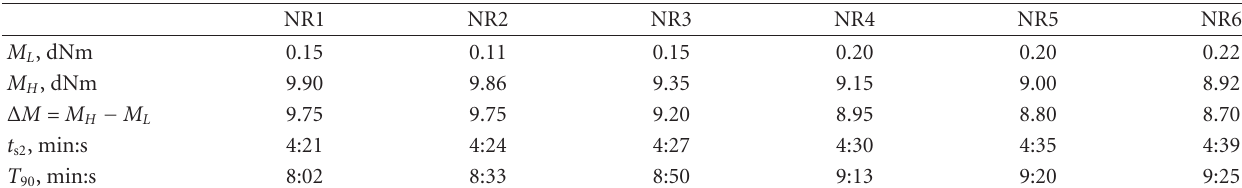
Table 2: Vulcanization characteristics of the rubber compounds investigated.